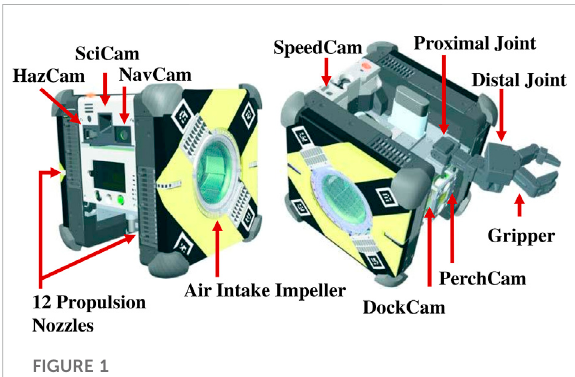
FIGURE 1 Illustration and annotation of the Astrobee free- fl yer vehicle (Lee et al.,